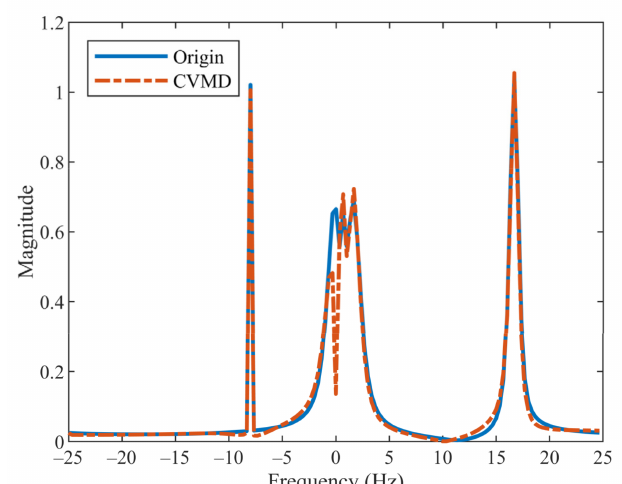
Figure 1. Spectrum of the original signal (blue solid line) and the reconstruction signal by CVMD (red dash-dot line).